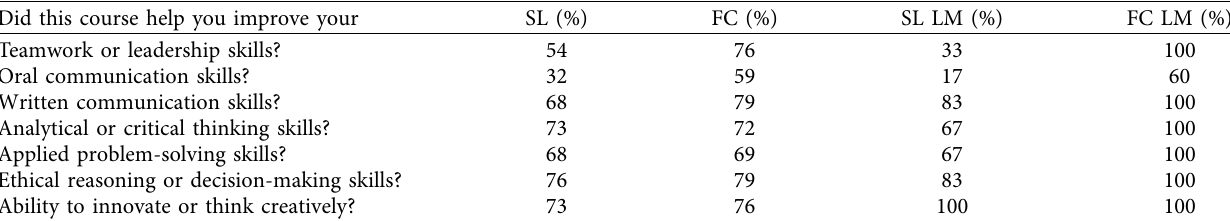
Table 2: Self-perceived improvements in core competencies for classroom